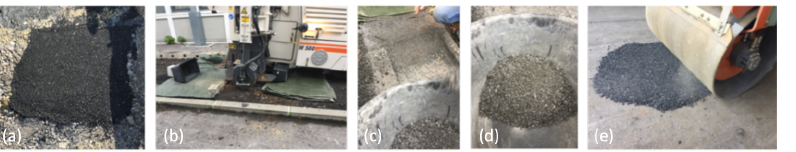
Figure 1. Preparation of the PU-RAP: ( a ) PU-asphalt pavement section on construction site. ( b ) Milling of the PU pavement. ( c ) View on the milled fractions after milling. ( d ) PU-RAP placed in bucket ( e ) Crushing of the PU-RAP by a roller compactor.